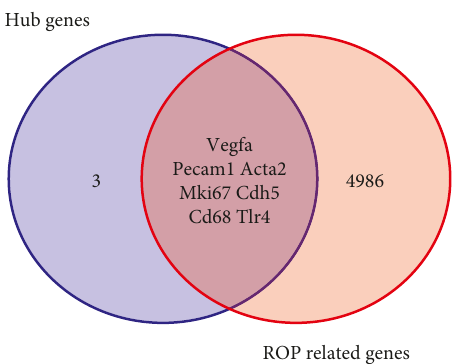
Figure 6: Identified 7 hub genes from the Comparative Toxicogenomics database.